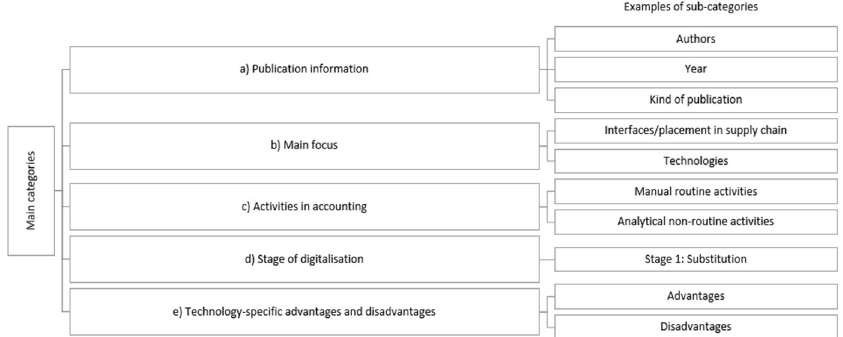
Fig. 3 Coding tree with sample